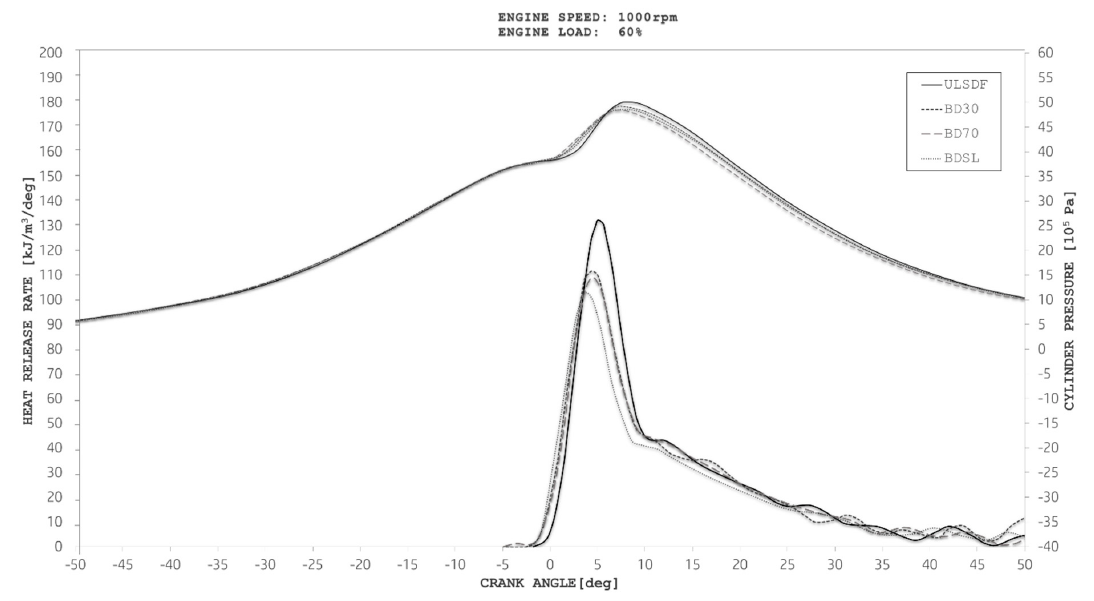
Figure 3. The dependence of fuels on the heat release rate and cylinder pressure (1000 rpm / 60%).